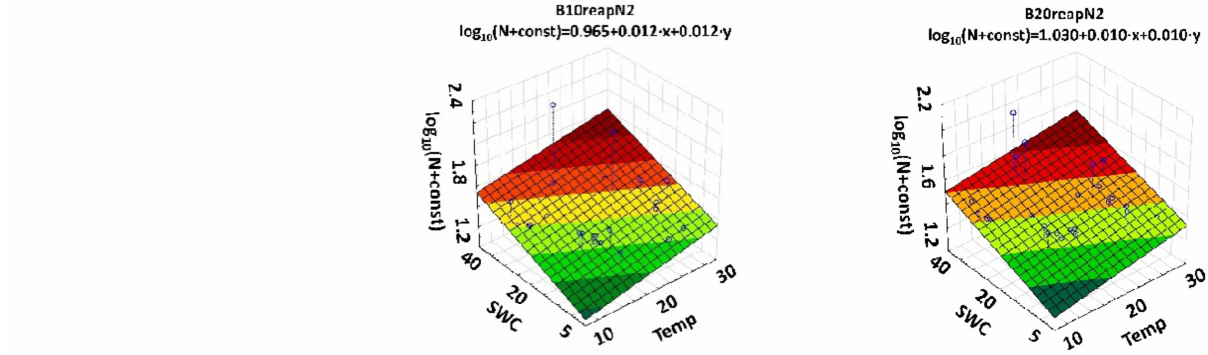
Figure 4. Three-dimensional plots with regression equations for the N 2 O emission versus soil temperature (X axis) and soil moisture (Y axis) content for all the combinations of N-fertilizer and biochar. For better visualization of the log (N + const) regression function values, they are color coded from green (lowest value) to red (highest value).